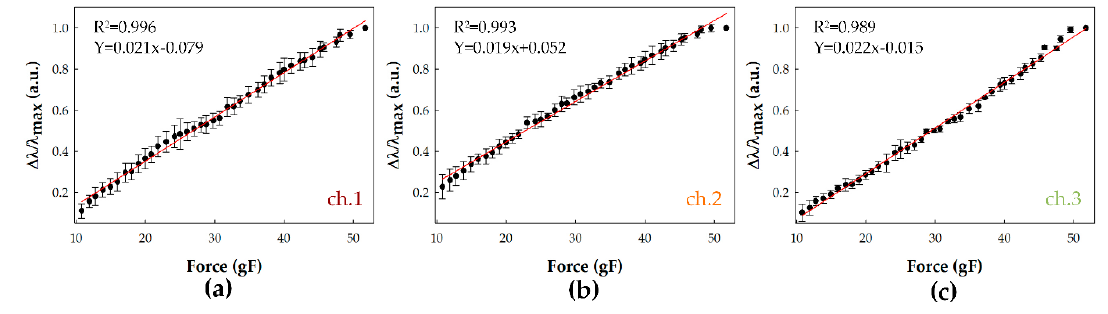
Figure 3. The calibrated wavelength output response under every 1 gF axial loading for three channels of FBG force